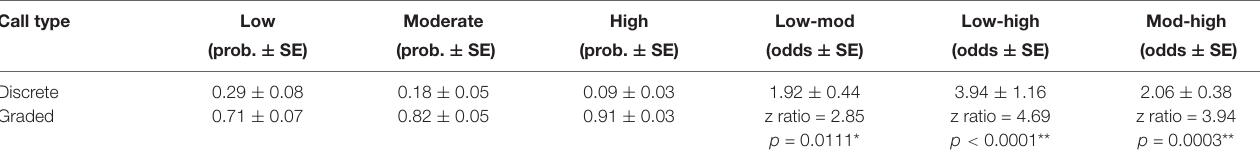
TABLE 3 | Results from the generalized linear mixed models with the probability of detecting discrete and graded calls in each intensity level in the first three columns, and the odds ratios in the last three columns. Call type